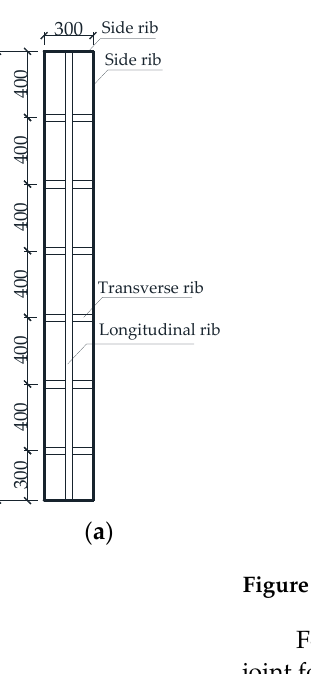
Figure 7. Schematic diagram of joint formwork installation. The mechanical properties and density of materials for formwork and components are presented in Table 4.